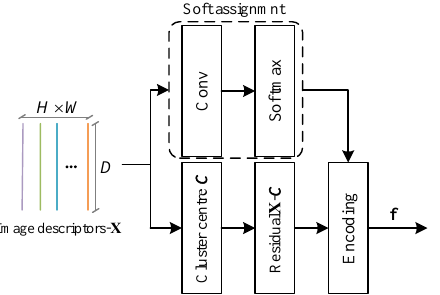
Figure 3. The configurations of the proposed FV layer. Convolution kernel size is 1 ×